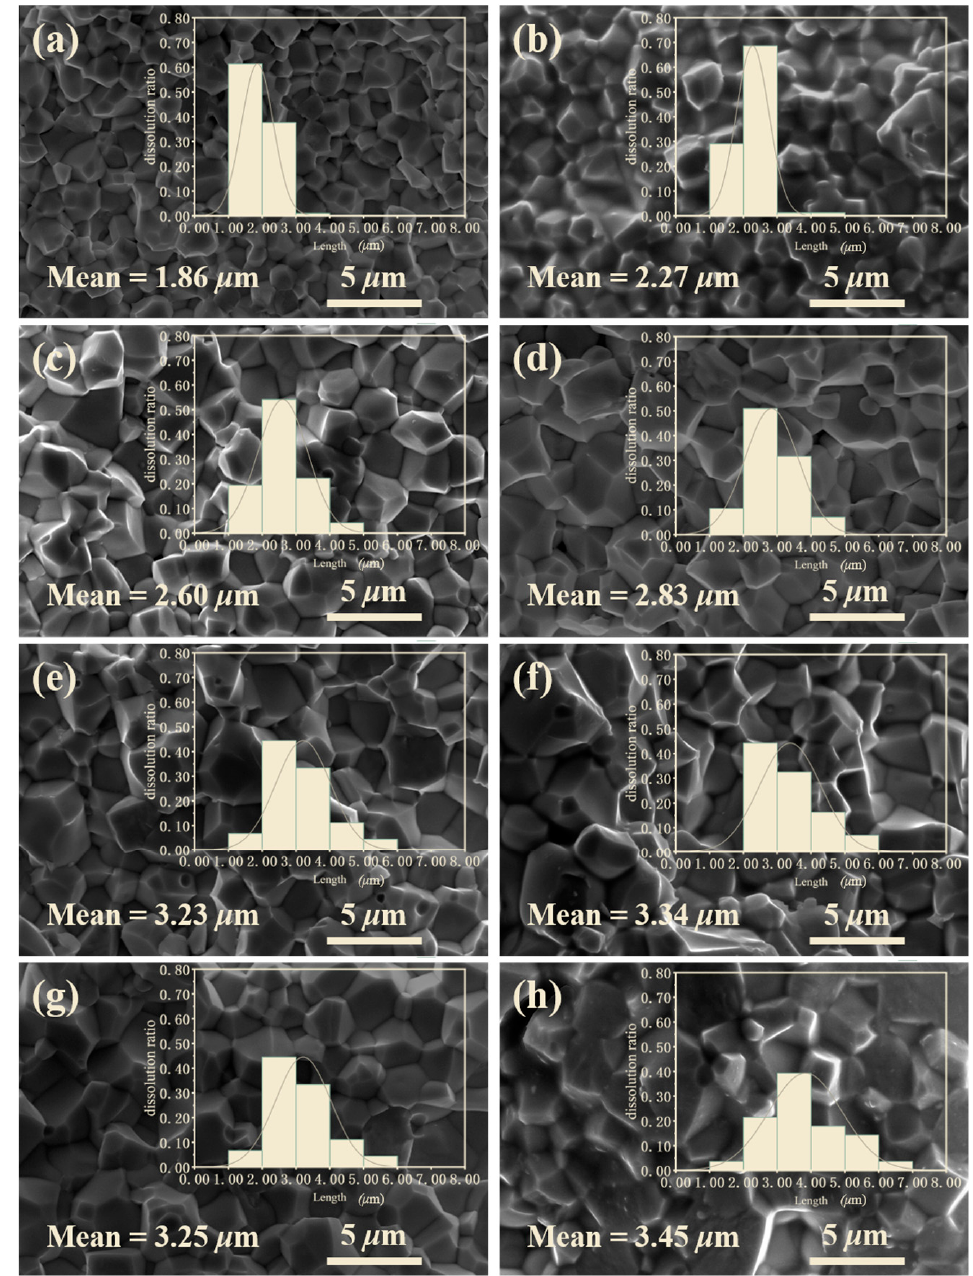
Figure 2. SEM images and grain size distribution for the 0.2 wt% Li 2 CO 3 -modified ceramics sintered at various temperatures: ( a ) 900 °C; ( b ) 920 °C; ( c ) 940 °C; ( d ) 960 °C; ( e ) 980 °C; ( f ) 1000 °C; ( g ) 1050 °C; ( h ) 1100 °C.